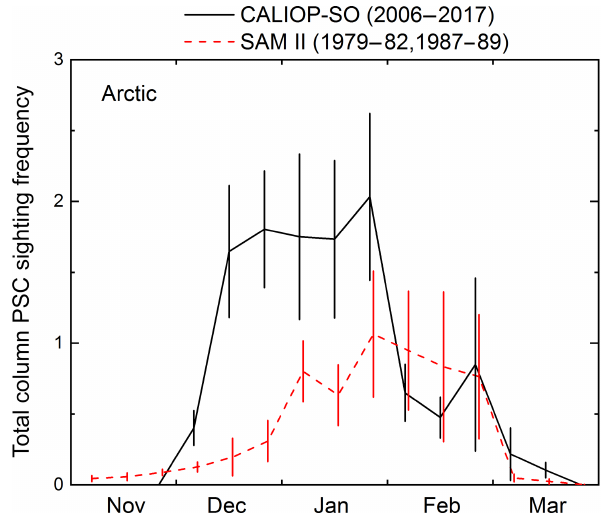
Figure 30. Multi-year mean Arctic PSC column occurrence fre- quency from November to March for CALIOP-SO (black solid) and SAM II (red dashed), along with standard errors in the